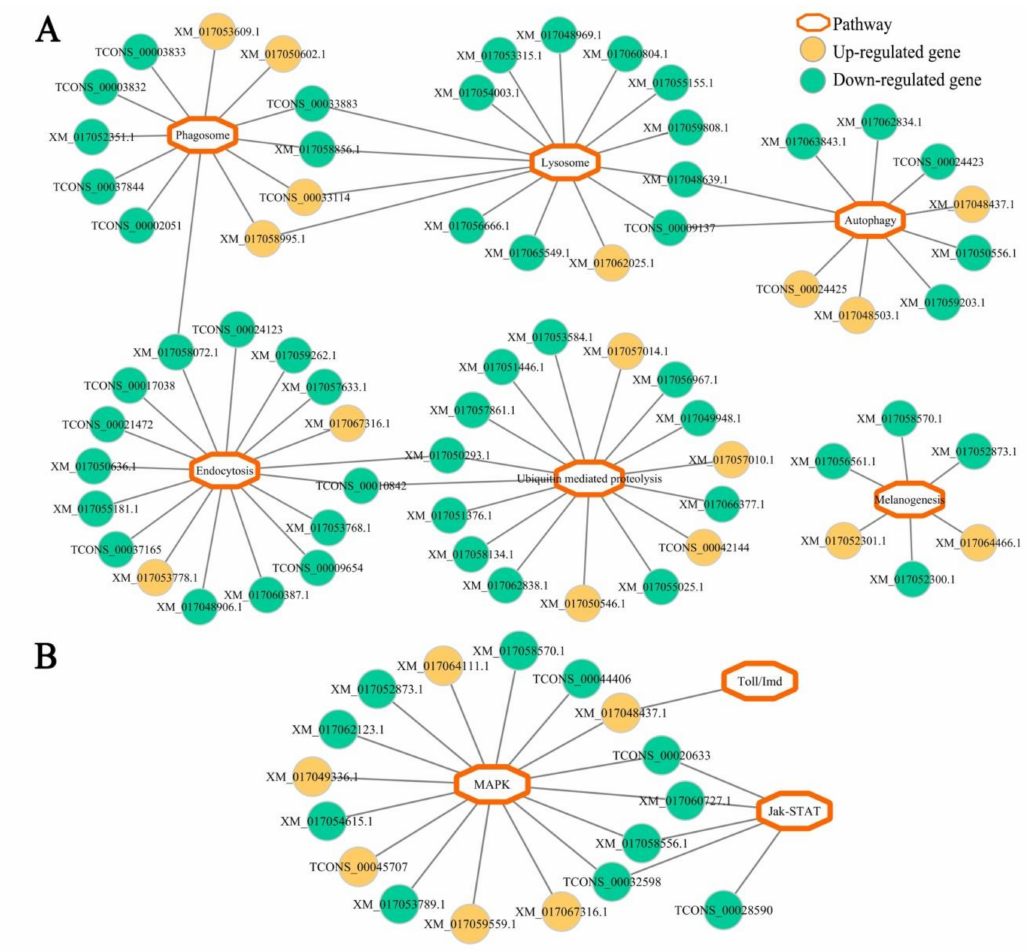
Figure 6. Enrichment network of host DEGs associated with cellular ( A ) and humoral ( B ) immune pathways in AcCK1 vs. AcT1 comparison